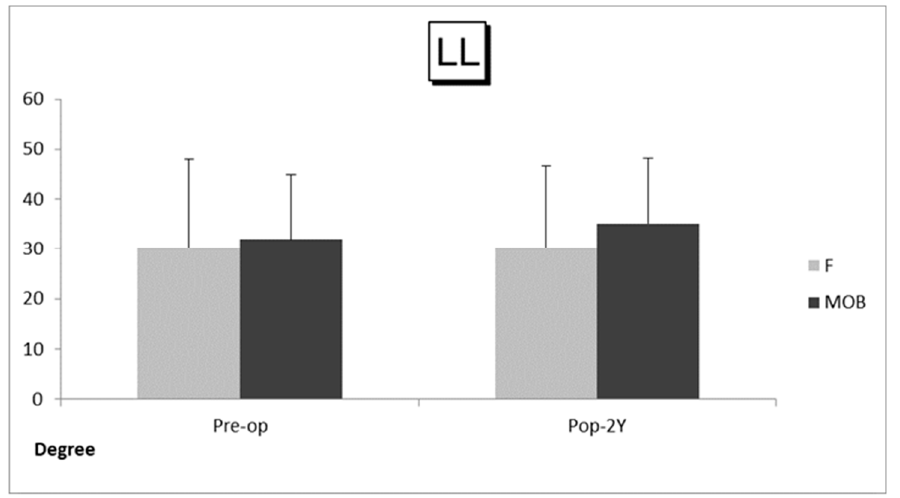
Figure 1. Angle of lumbar lordosis (LL) in the MOB patient group (MOB group) and the first surgical patient group (F group). The bars depict preoperative and follow-up average values and standard deviations in each group. Abbreviations: Pre-op, before surgery; Pop-2Y, at 2 years after surgery. The preoperative JOABPEQ averaged 36.3 points in the MOB group and averaged 35.4 points in the F group. The postoperative average JOABPEQ was 75.4 in the MOB group and 70.2 in the F group. The preoperative JOA scores averaged 12.5 points in the MOB group, and averaged 11.6 points in the F group. The postoperative JOA scores averaged 23.9 points in the MOB group, averaged 24.7 points in the F group. In comparing the clinical outcomes, the JOABPEQ and the JOA scores were significantly improved after surgery compared with before surgery in both groups, but no significant difference was observed between the two groups ( p = 0.474 in the JOABPEQ, p = 0.327 in the JOA scores) (Figure 3). No major complications were observed, and there were no characteristic complications concerning LLIF in each group (Table